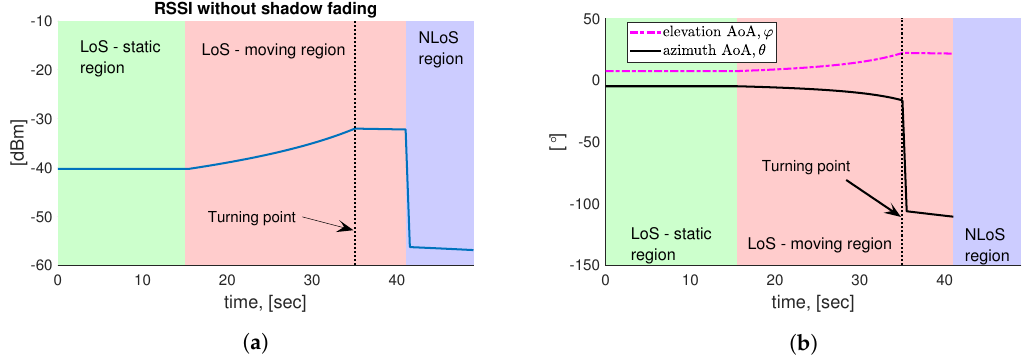
Figure 6. Simulation-based numerical characterization as a function of time along the simulated robot trajectory (see Figure 3b). ( a ) The received signal strength indicator (RSSI) applying InH office pathloss model ([52] Table 7.4.1-1); ( b ) Noiseless AoA with respect to mmWave AP. Table 3. Utilized simulation